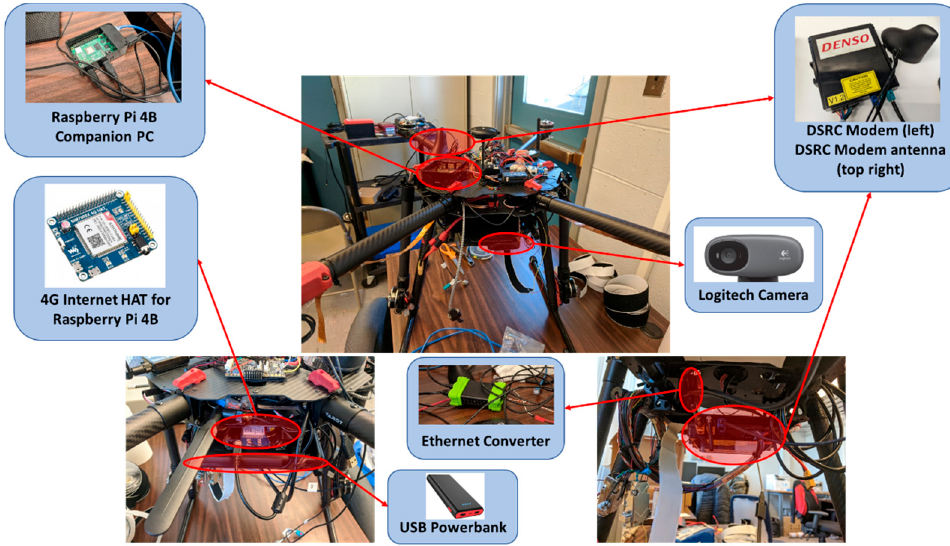
Figure 5. UAV platform equipped with hardware.